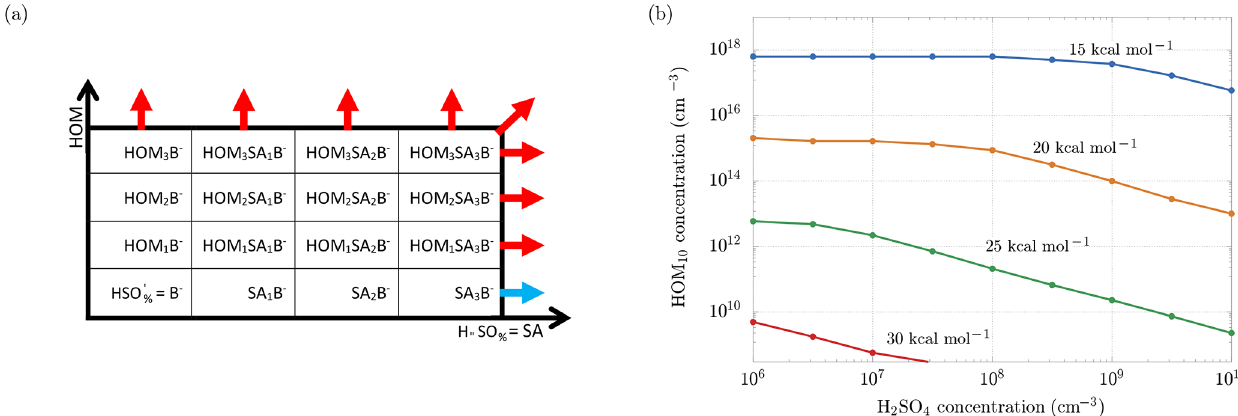
Figure 11. (a) Clusters involved in the ACDC simulations. Out of the box, the clusters are considered to be stable and contributing to new- particle formation. The blue arrow indicates the flux of the outgrowing cluster that contributes to the formation rate of only sulfuric acid particles ( J sa ). After adding HOM 10 monomers to the system, new outgrowing HOM clusters (red arrows) are participating in new-particle formation, resulting in a total formation rate J sa + hom . (b) Concentrations of HOM 10 needed to increment the new-particle formation rate by 1cm − 3 s − 1 , for different decomposition